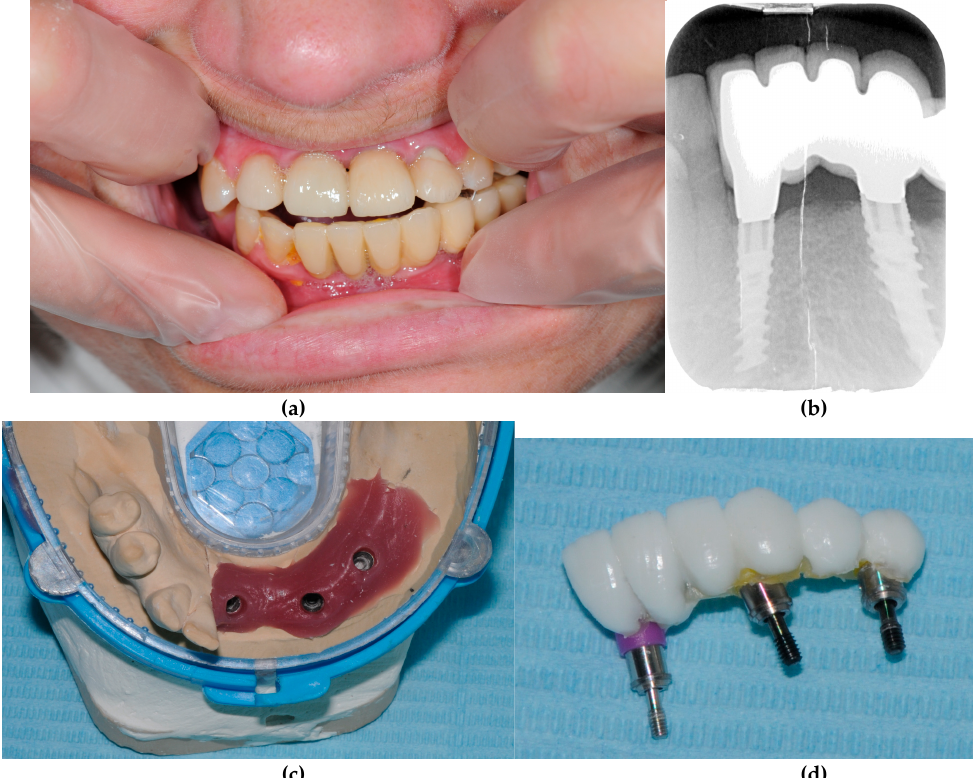
Figure 4. Patient 7 (-PD-FI). ( a ) Clinical view. ( b ) Radiographical view. ( c ) Prosthetic work model. ( d ) Dental prosthesis before being placed. The three implants were still in good shape two years after their placement.